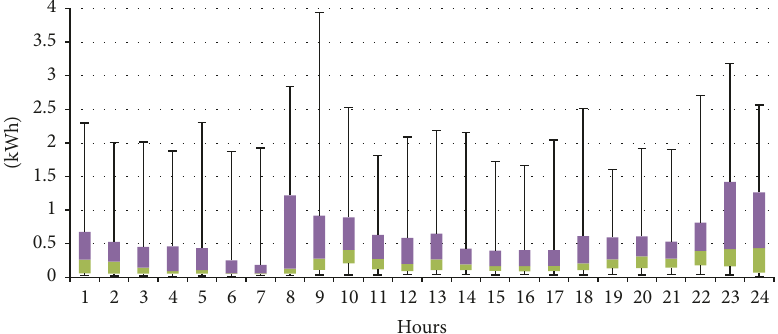
Figure 3: Customer with the most volatile consumption (in kWh) in the analyzed period (1 March 2013 to 28 February 2014).